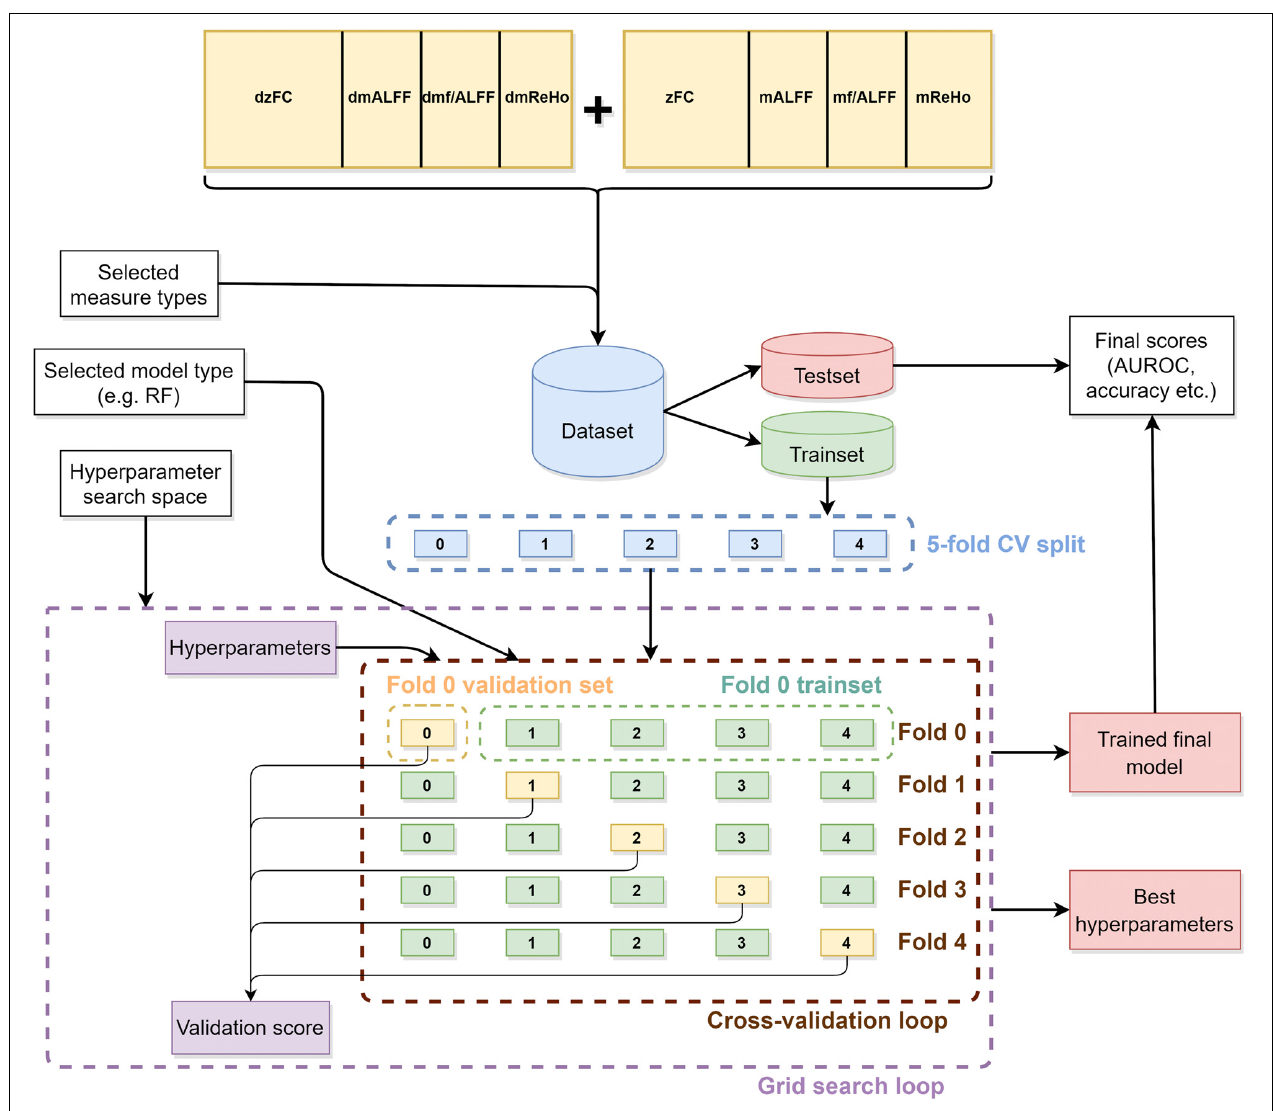
FIGURE 2 | Illustration of the machine learning classification